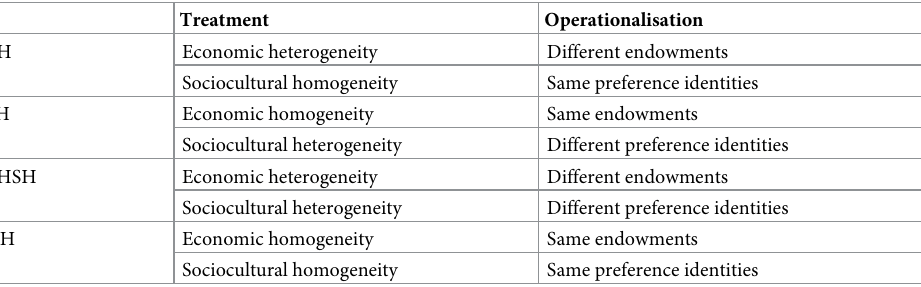
Table 2. Overview of